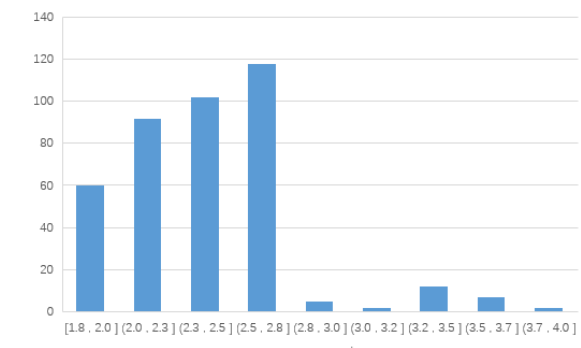
Figure 14. The positioning accuracy in experimental